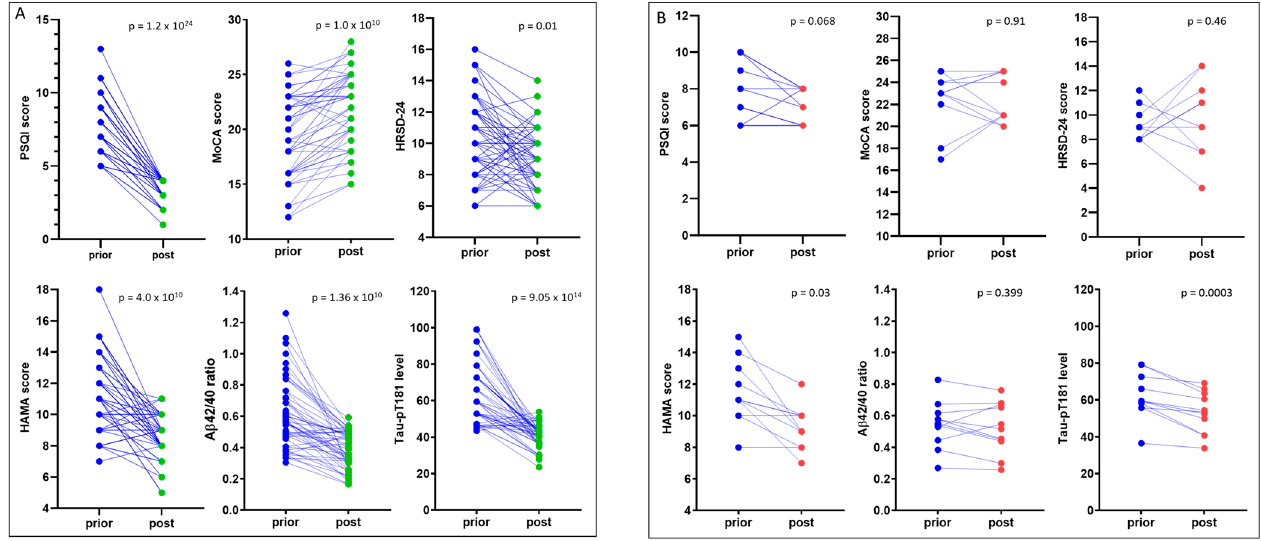
Figure 4. Different improvements in recovered (panel A ) and unrecovered (panel B ) subgroups. The neuropsychological scores, blood A β 42/40 ratio, and Tau-pT181 protein level were presented as case-controlled pairs of prior- and post-treatment values. The p values were derived from a pair-wise t-test.